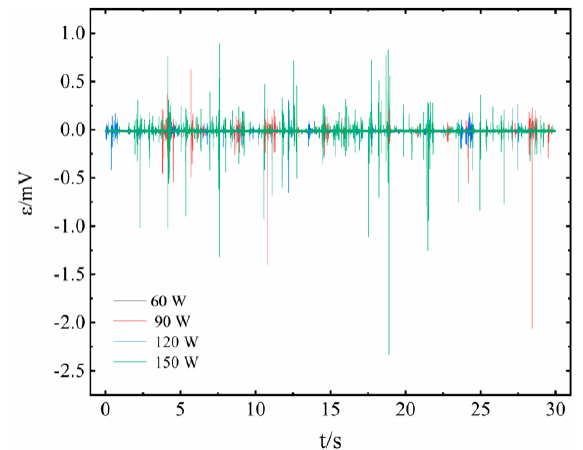
Figure 7. The induced voltage signal with different heat input.